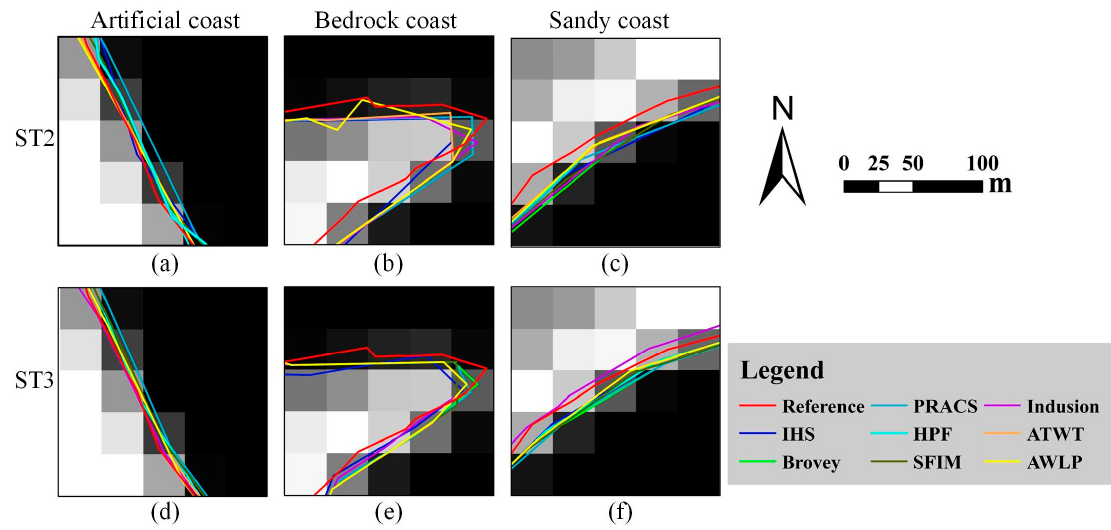
Figure 7. The positions of coastlines extracted from ten different pansharpening algorithms for three subsites.